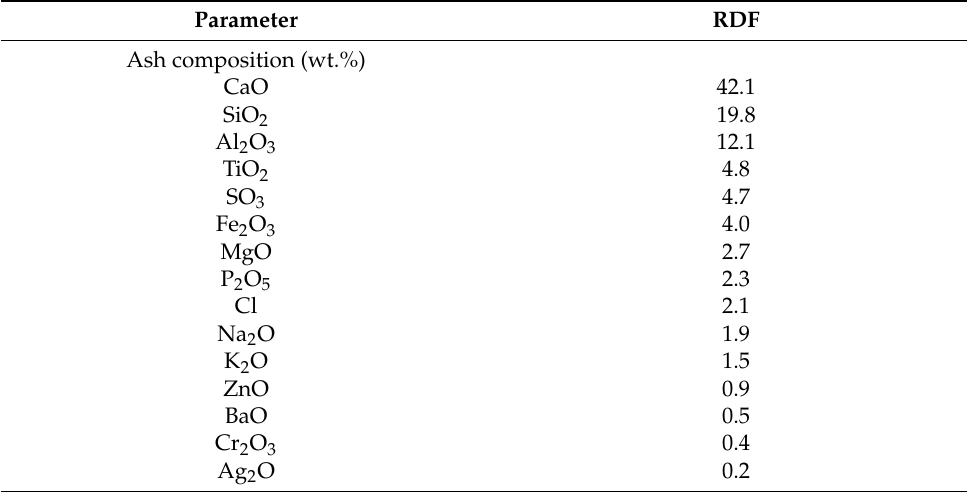
Table 2. Composition of RDF ash.